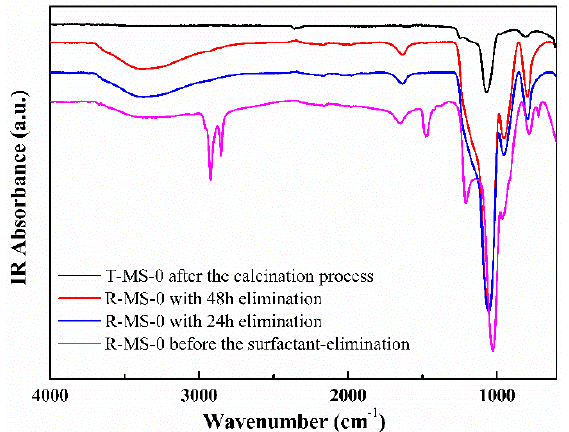
Figure 1. FT-IR spectra of the room-temperature-synthesized mesoporous silica. The magenta line represents the spectrum before the removal process of the surfactant, and the red and blue lines indicate the spectrum after the elimination processes for 48 and 24 h, respectively. The black line is the FT-IR spectrum of mesoporous silica made by the calcination process.